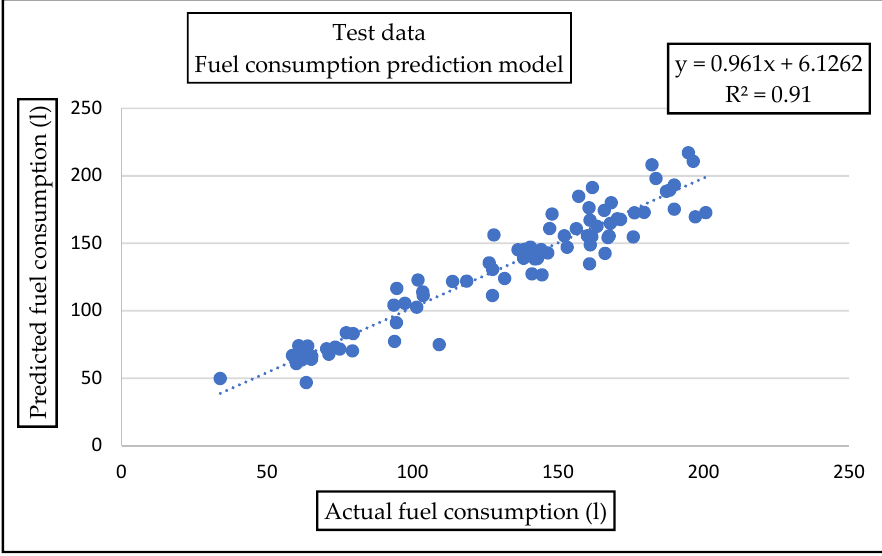
Figure 6. R 2 values of actual and predicted fuel consumption for test data using ANFIS.